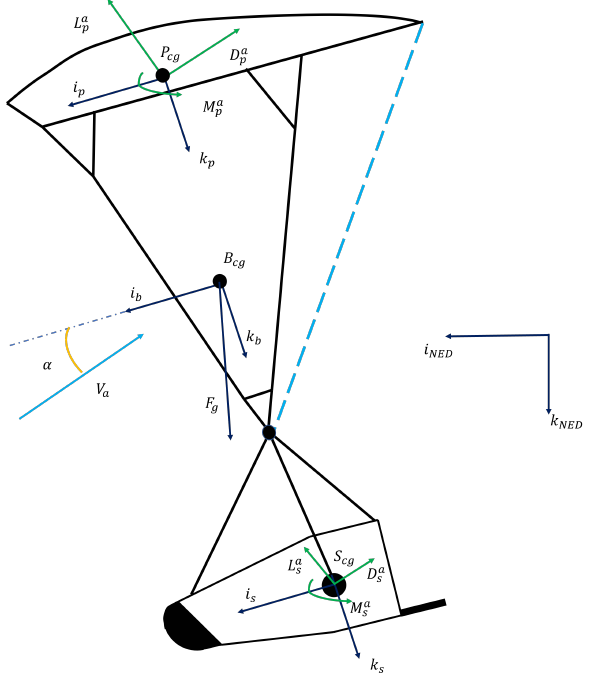
Figure 5. 6 DOF model graphical representation of the parafoil–payload system highlighting the main forces and moments acting on